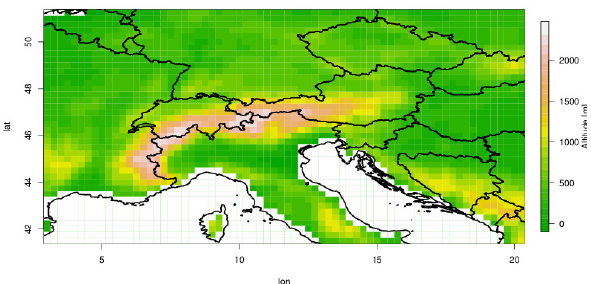
Fig. 1. The greater Alpine area Fig. 1 the Greater Alpine Area map